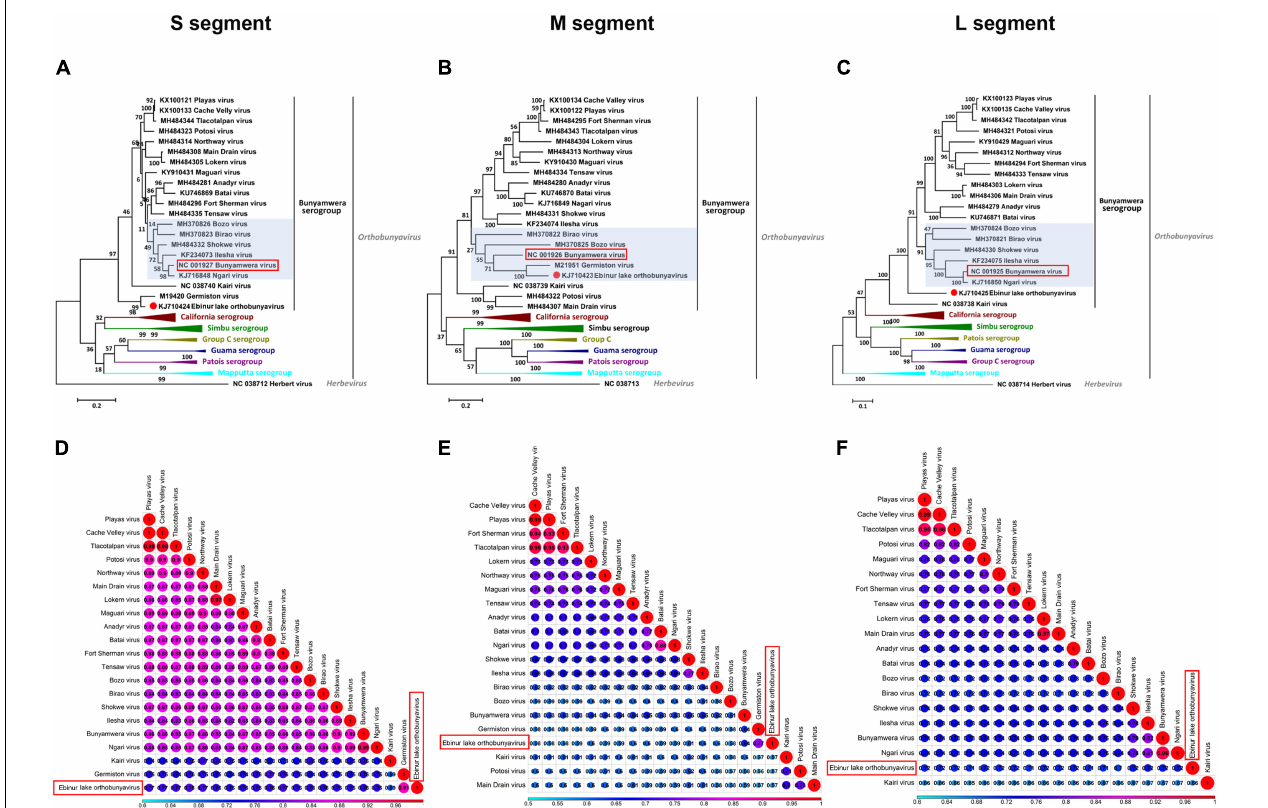
FIGURE 2 | Maximum likelihood phylogenetic trees (A–C) and pairwise distance (D–F) based on alignments of nucleotide sequences of orthobunyaviruses. The scale bar indicates the evolutionary distance in the number of substitutions per nucleotide substitution/site, and the principal bootstrap support levels are indicated. Branches are color coded according to group. The Herbert virus was used as an outgroup in the ML trees.